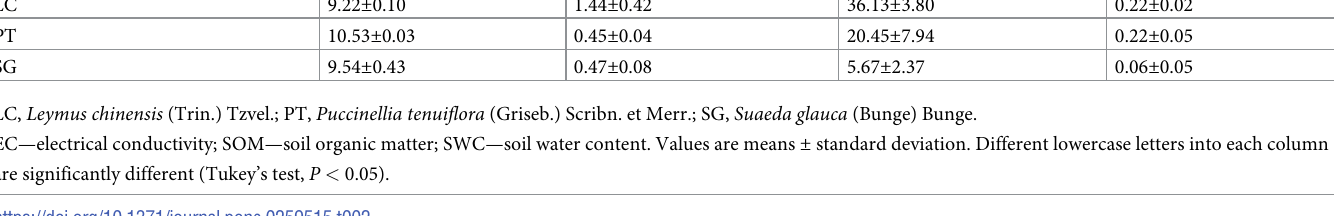
Table 2. Soil physicochemical properties under three halophytes. Rhizosphere samples